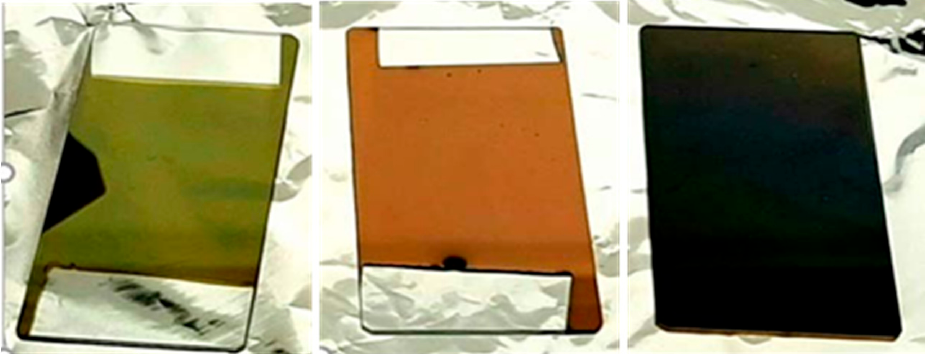
Figure 2. Sputtering parameters variation resulting in three different colored TiN films; green, gold, and grey (from left to right). The pH sensing properties of green, gold, and grey colored TiN films are tabulated in Table 2. The pH sensitivity was determined by the slope of the potential difference (mV) versus time (seconds), the intercept of the slope was the E 0 potential, hysteresis was the difference in the electrochemical potentials measured at the same pH level, and drift was the difference between the peak potential value and the 90% value of the saturated potential. The gold film exhibited Nernstian sensitivity of − 59 mV/pH while, both the green and grey films had a sub-Nernstian pH sensitivity of − 55 mV/pH. The gold film exhibited the best characteristics with the least hysteresis and drift of 1.2 mV and 3.9 mv/h, respectively. Consequently, the gold-colored film was adopted as the optimal material, and its color chromaticity and sensing properties were subsequently investigated. Table 2. pH sensing properties of colored TiN films.